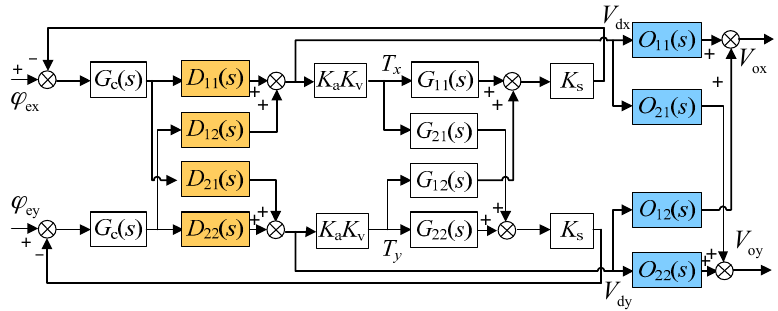
Figure 7. Block diagram of the rebalance loop in verification of the outer loop decoupling compensation.